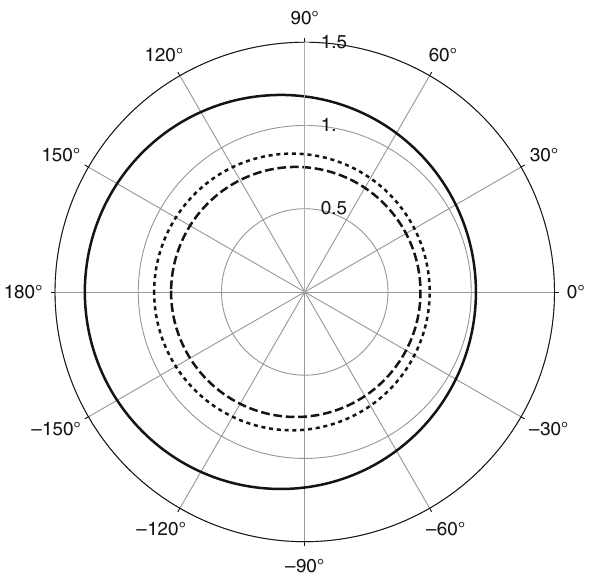
Fig. 2 Dependence of d 2 σ/ d φ e d θ e on φ e for the standard V − A inter- action, E ν = 1MeV: θ e = π/ 12 (dotted line), θ e = π/ 6 (solid line), θ = π/ 3 (dashed e